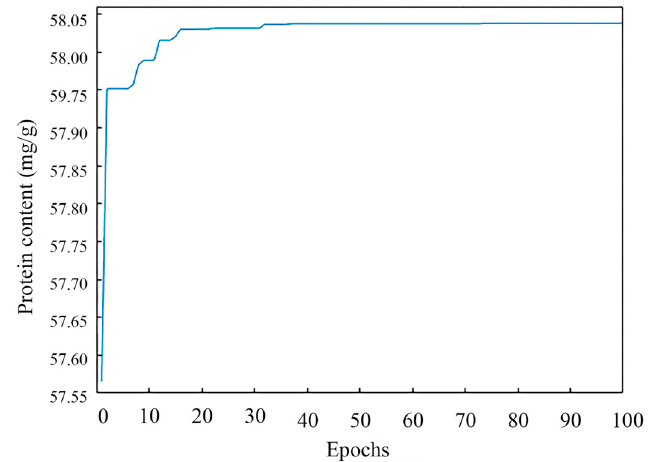
Figure 6. The genetic algorithm convergence process.